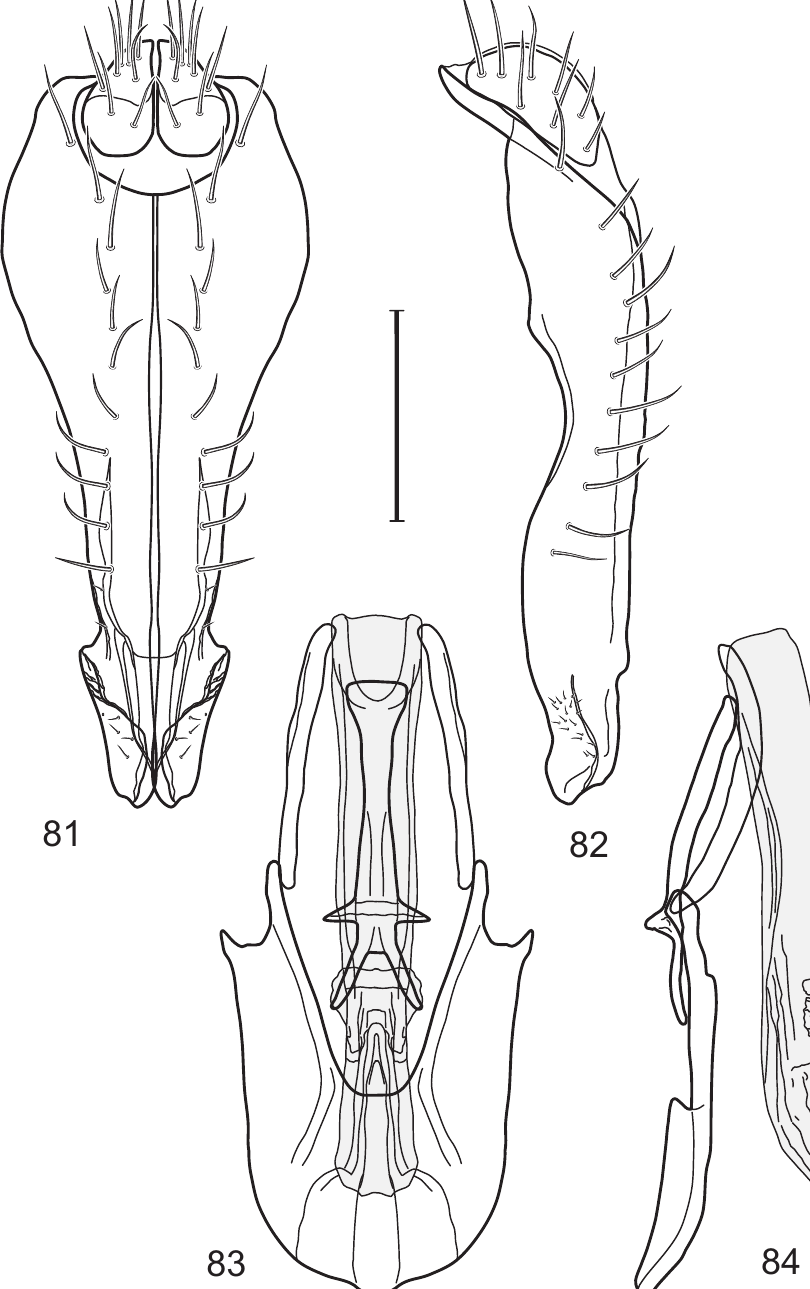
Figures 81–84. Hydrochasma falcatum sp. n. (Peru. Madre de Dios: Río Manu, Erika) 81 epandrium and cerci, posterior view 82 same, lateral view 83 internal structures of male terminalia (aedeagus [shaded], phallapodeme, gonite, hypandrium), ventral view 84 same, lateral view. Scale bar = 0.1